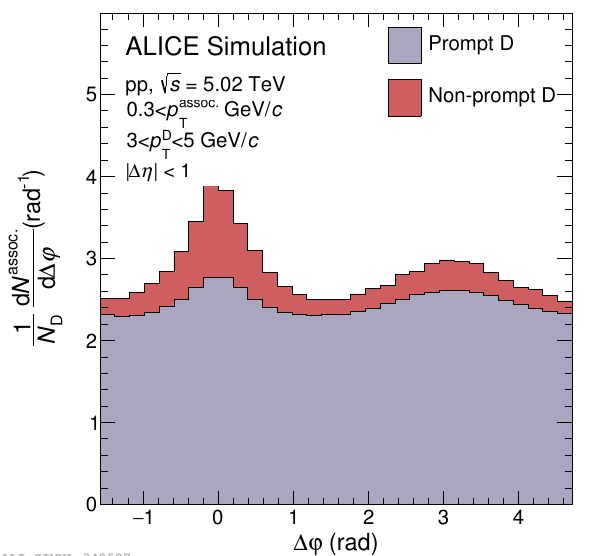
Figure 6. Associated yield of prompt and non-prompt D meson correlations with hadrons in simu- √ s = 5.02 TeV for p assoc. lated pp collisions at